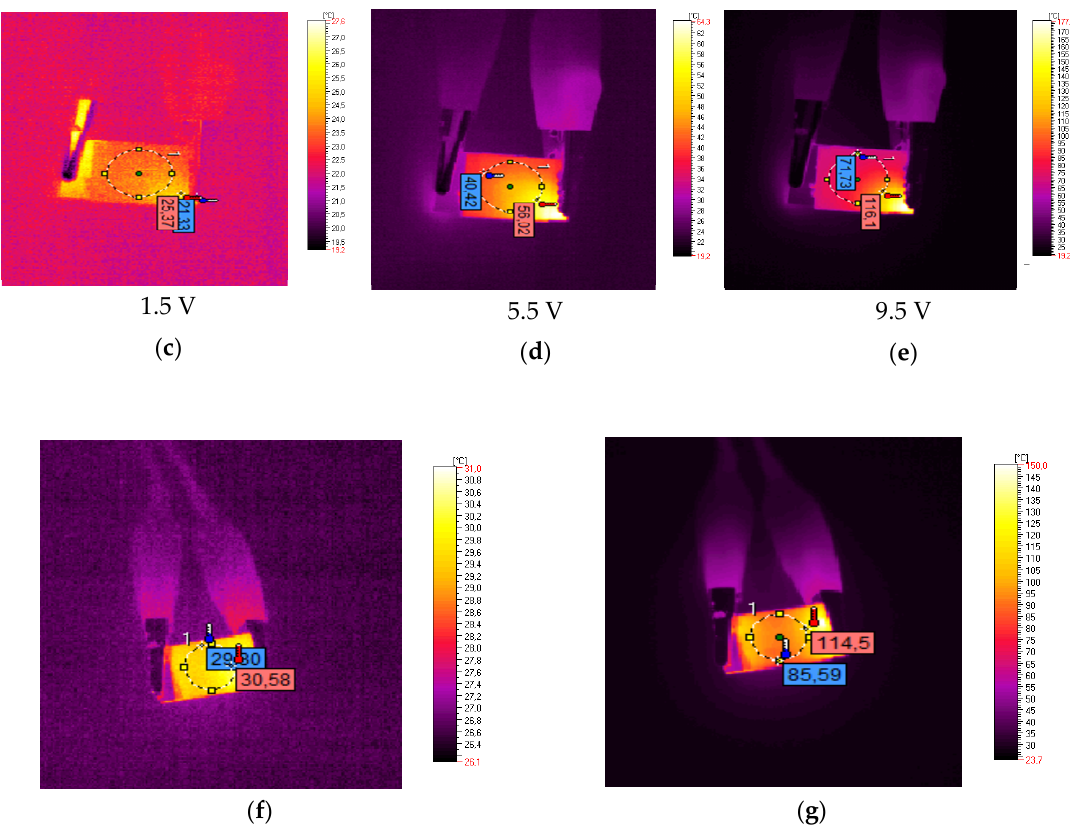
Figure 7. The correlation of temperature (a ) and current flow ( b ) versus applied potential for constructed devices containing bTAThDaz and spiro -OMeTAD, as organic layer, together with IR images recorded at 1.5 V ( c ), 5.5 V ( d ) and 9.5 V ( e ) for bTAThDaz, and at 1.5 V ( f ) and 7 V ( g ) for spiro -OMeTAD, obtained for constructed devices with architecture glass/ITO/organic layer/Ag/ITO/glass.